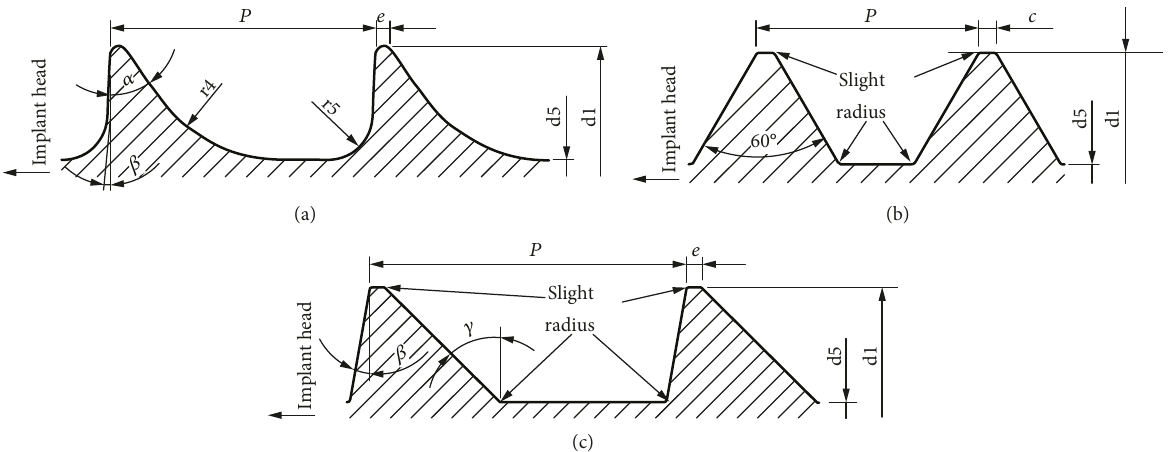
Figure 1: Thread types included in analyses. (a) HA: shallow thread [27]. (b) HC: symmetrical thread [28]. (c) HD: asymmetrical thread [28].